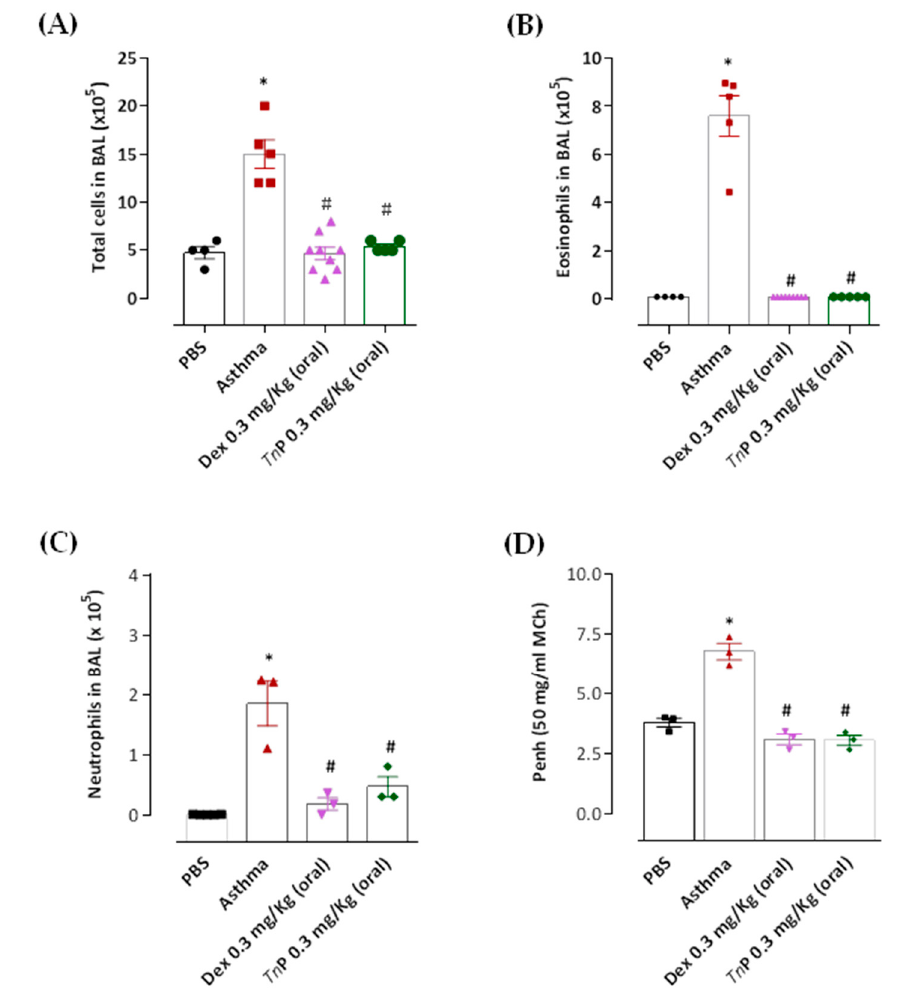
Figure 1. Effect of Tn P on airway inflammation and airway hyperresponsiveness (Ahr) . Twenty- four hours after the last aerosol challenge, BAL from control, asthma, Tn P, or Dexa groups was collected for leukocyte ( A ), eosinophil ( B ), and neutrophil ( C ) counts. MCh responsiveness was assessed as changes in enhanced pause (Penh) in conscious animals using a whole-body plethys- mography ( D ). The results represent the mean ± SEM of 3–5 animals/group. * p < 0.05 compared to the control group and # p < 0.05 compared to the asthma group.